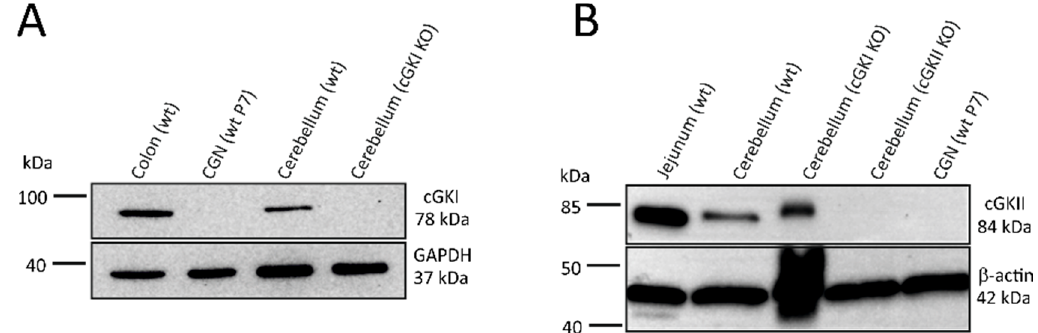
Figure 4. Western blot analysis failed to detect cGKI or cGKII expression in primary CGNs. ( A )